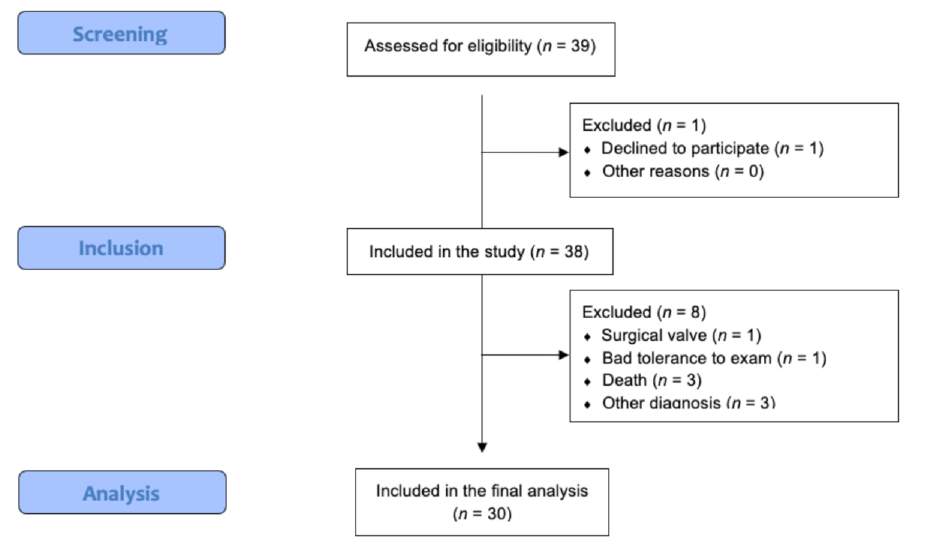
Figure 1. STROBE flow diagram. Table 1. Demographics and clinical characteristics of patients included ( n =